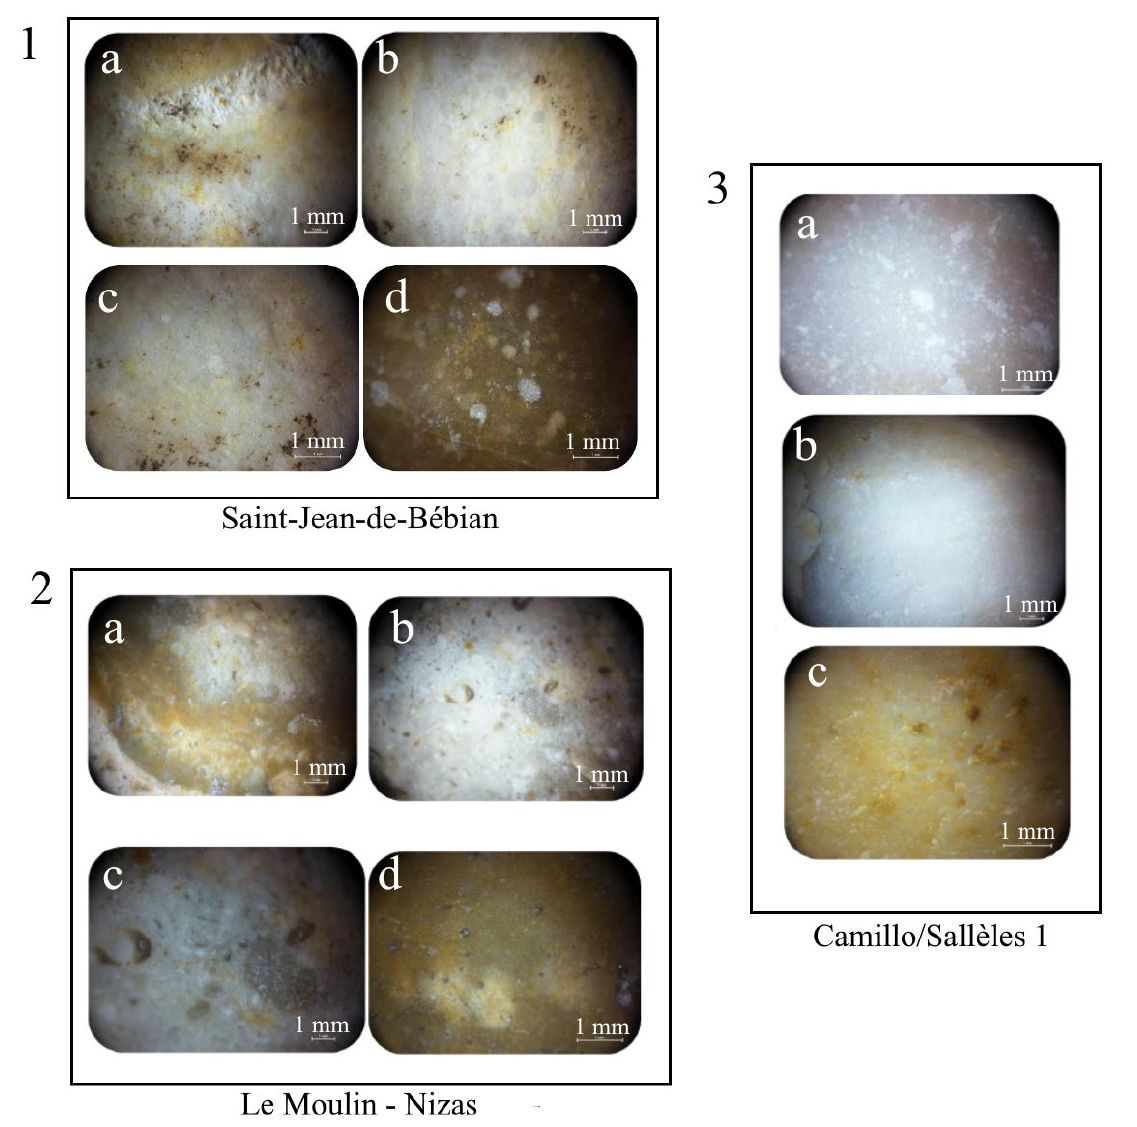
Figure 5. Flint facies. 1. Saint-Jean-de-Bébian, a: General view of the siliceous crystalline matrix with white patina and hematite inclusions, b: Heterometric ooliths, c: Non patinated part with flaky inclusions, d: Ooliths and hematite inclusions. 2. Le Moulin, Nizas, a: General view with yellow and white zonations, graphic patina, b: White zonations in details with numerous heteromorphic oolithis and foraminifers (coccolithophoridés), c: Debris and goethite, d: Yellow zonations with automorph quartz, geodes and peloids. 3. Camillo and Sallèles 1, a and b: General view of the grey sparite and iron oxides spots, c: Siliceous crystalline matrix and iron oxide